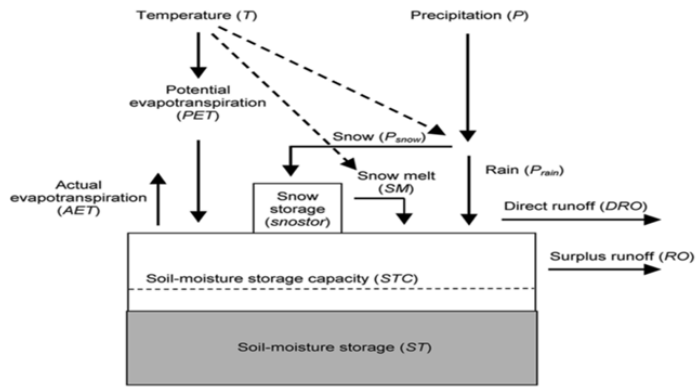
Figure 2. Diagram of the Thornthwaite water-balance model (adapted from [11]).